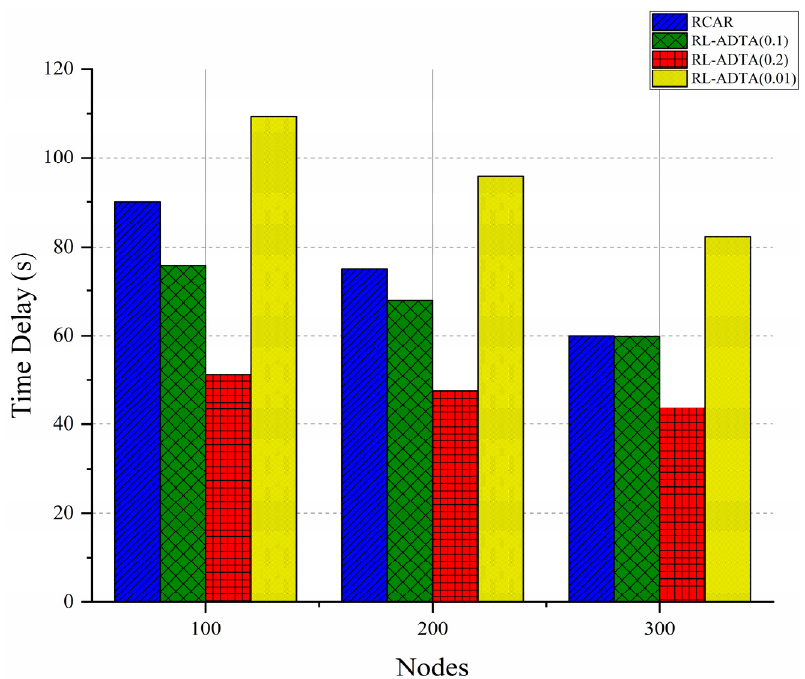
Figure 13. RCAR and RL-ADTA (0.1, 0.2, 0.01) delay comparison. The end-to-end delay of RCAR and RL-ADTA includes transmission delay, propagation delay, and processing delay.